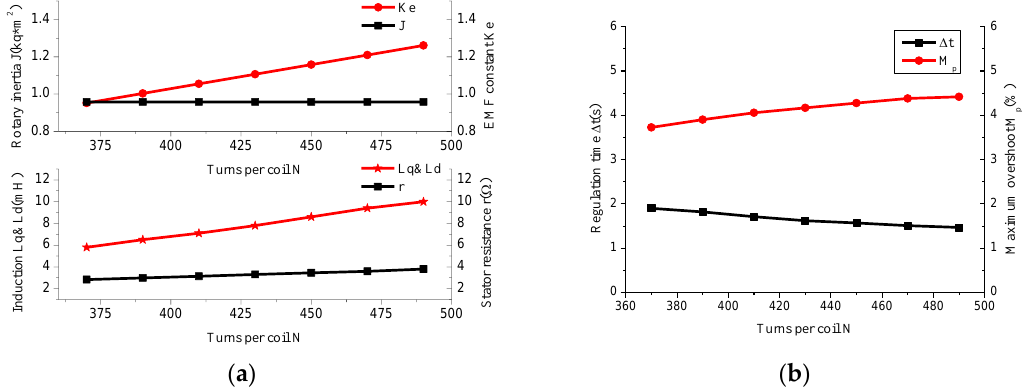
Figure 12. Influence of different turns per coil: ( a ) Model variables; ( b ) Dynamic characteristic response.